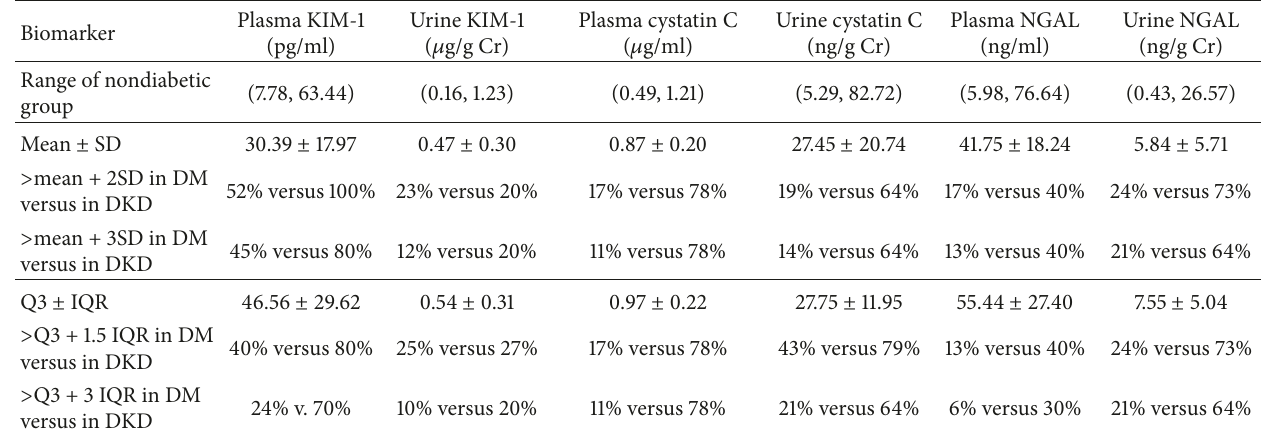
Table 2: Biomarkers of kidney injury in diabetic patients with no known kidney disease, nondiabetic controls, and diabetics with diagnosed kidney disease. DM: diabetes mellitus; DKD: diabetic kidney disease; KIM-1: kidney injury molecule-1; NGAL: neutrophil gelatinase- associated lipocalin; MCP-1: monocyte chemoattractant protein-1; Q3: upper quartile; IQR: interquartile